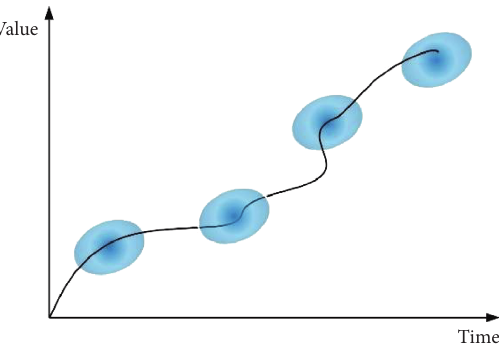
Figure 3: Working process of a particle